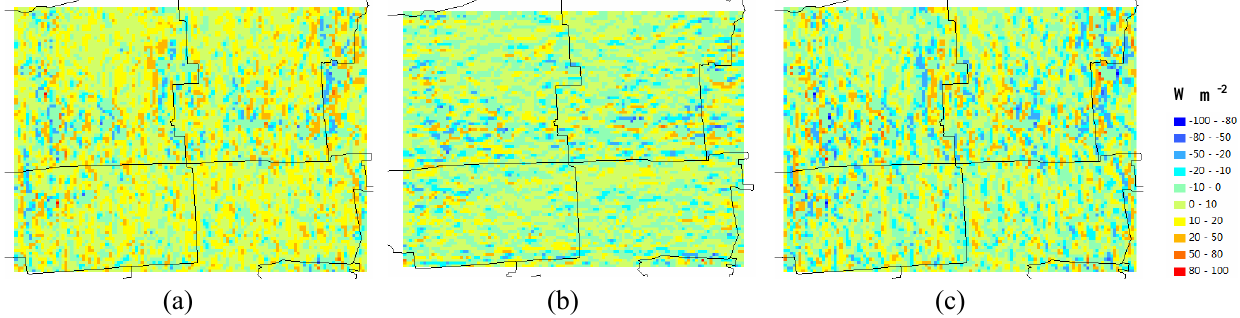
Figure 6. Surface solar flux deviations between the 3-D radiation parameterization and the plane-parallel scheme on 1 April at a grid resolution of 3arcsec (about 90m). (a) 07:00BT; (b) 12:00BT; (c) 17:00BT. The size of the simulation domain is the same as Domain 2 defined in Fig. 1. An elevation map at a 90m resolution for the simulation domain is also shown in the right panel of Fig. 1.